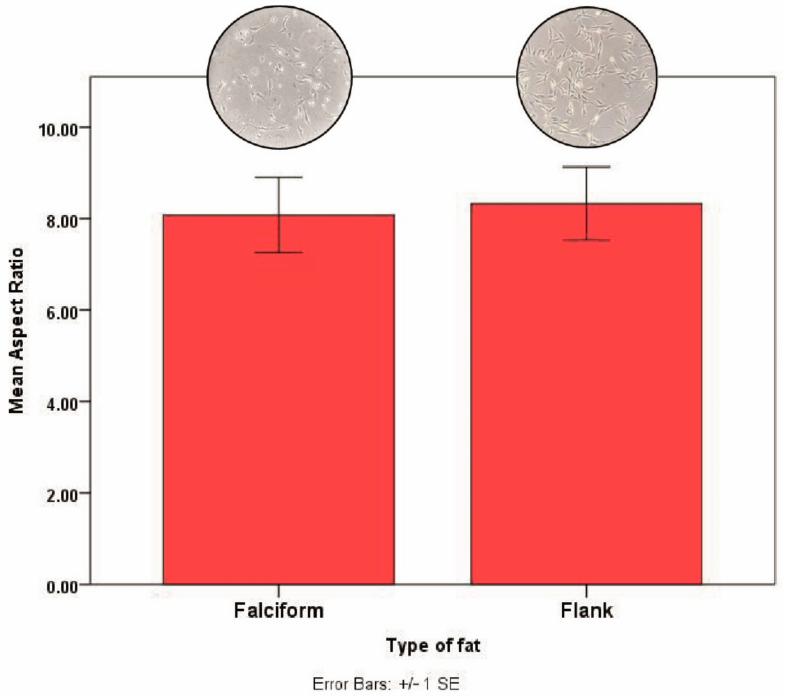
Figure 5. The mean aspect ratio (ratio of length/width) of AdMSCs harvested from the flank and falciform region were very similar ( p = 0.83). The error bars represent ± 1 standard error. Amplification factor of the